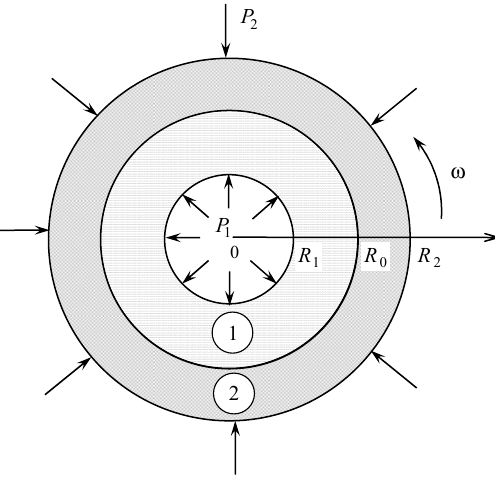
Figure 1. The scheme of the considered tribo-couple, where the inner and outer cylindrical layers are denoted by “1” and “2”, respectively; the thermal and force loadings are imposed on the inner and outer surfaces R 1 and R 2 and the frictional heating occurs on the interface R 0